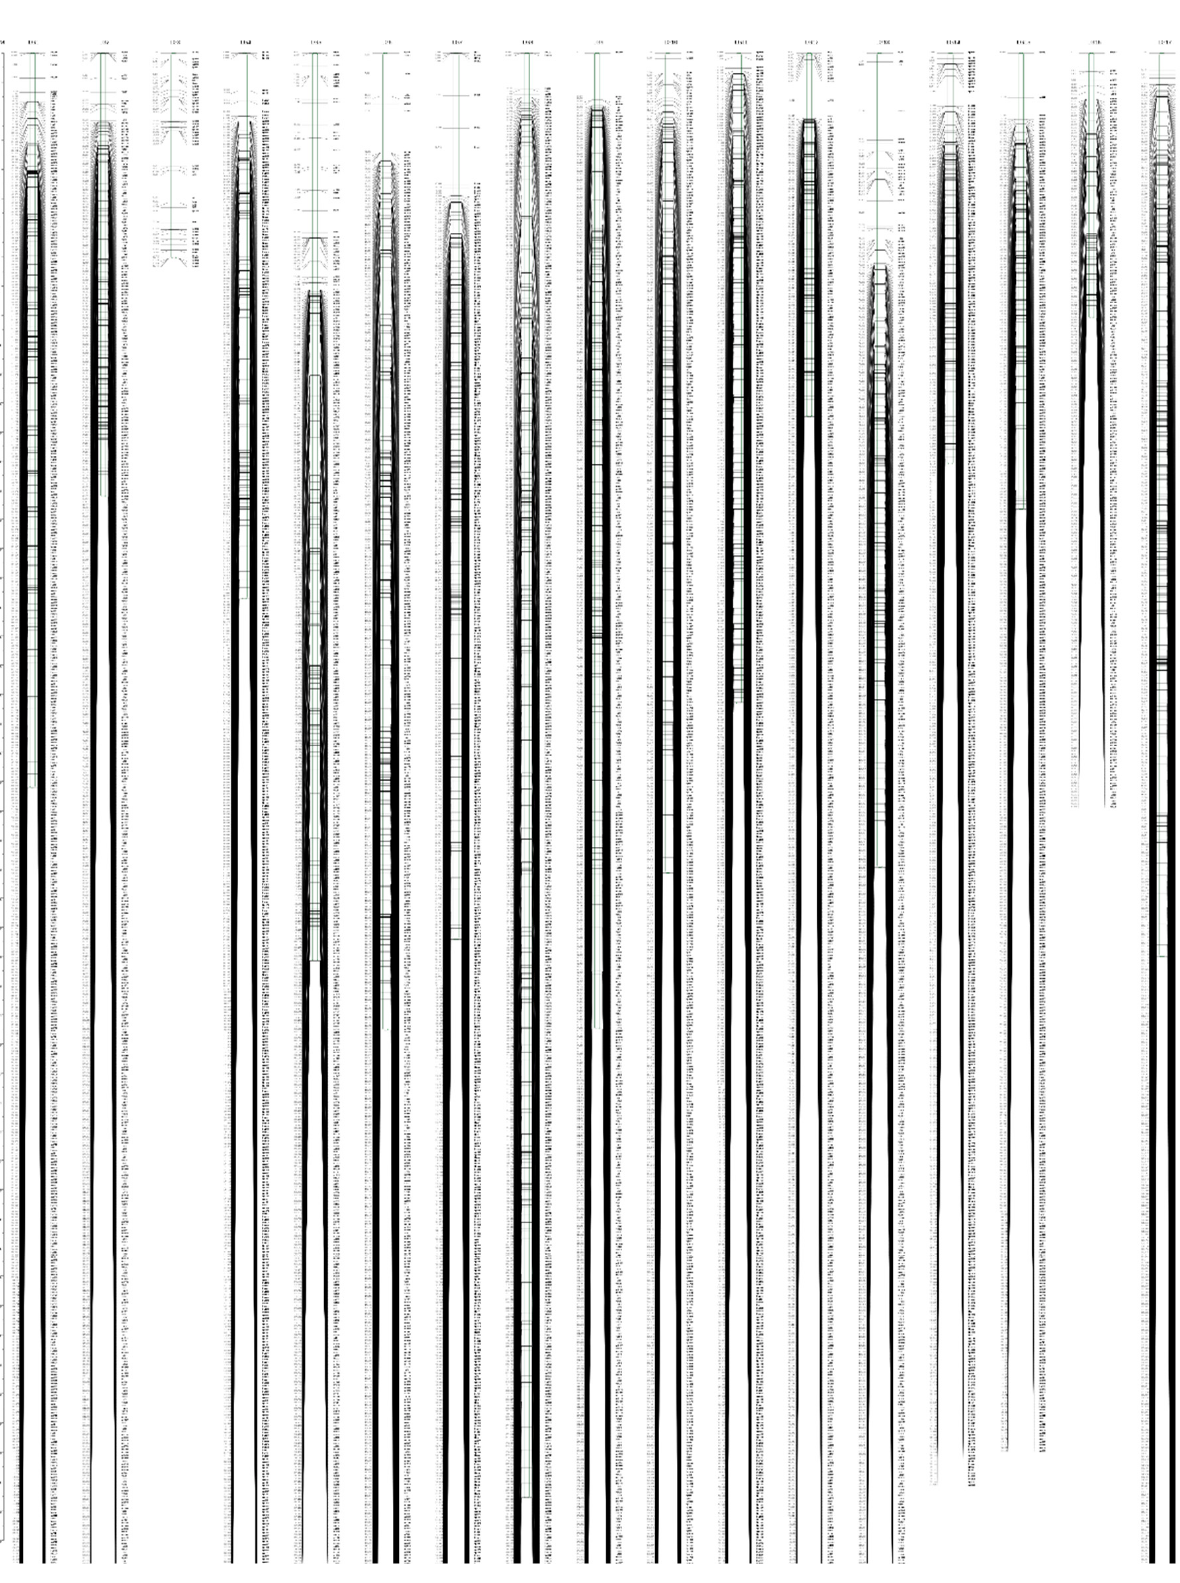
Figure 4. High-density integrated genetic map of E. ulmoides . The SNP markers and their location are shown on the right and left side, respectively.